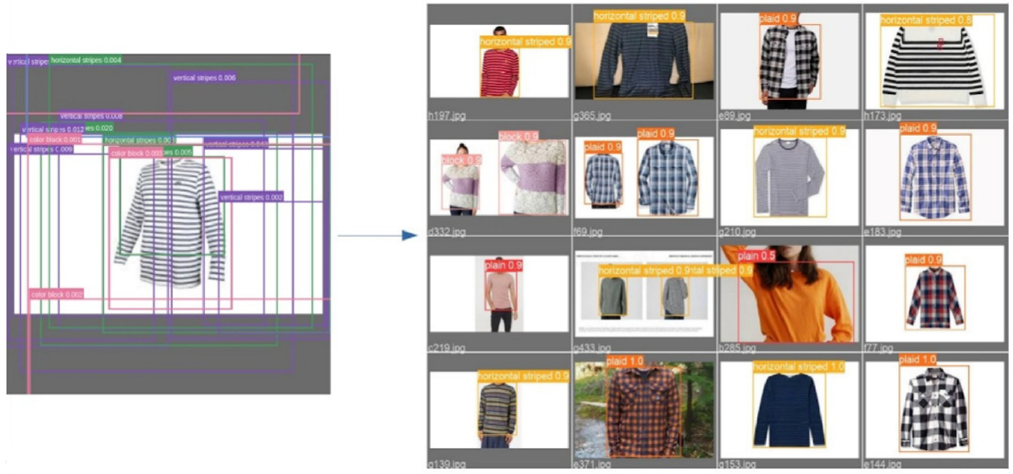
Figure 13. Object prediction by Head.